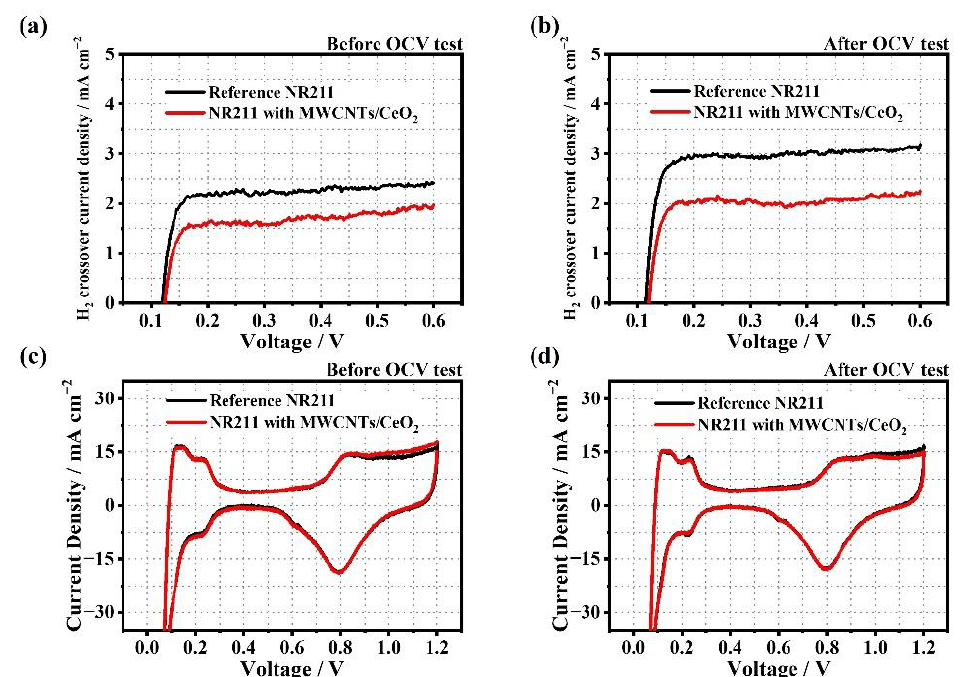
Figure 5. LSV spectra of the MEAs with the reference NR211 and the modified NR211 ( a ) before and ( b ) after the OCV holding test. CV spectra of the MEAs with the reference NR211 and the modified NR211 ( c ) before and ( d ) after the OCV holding test.